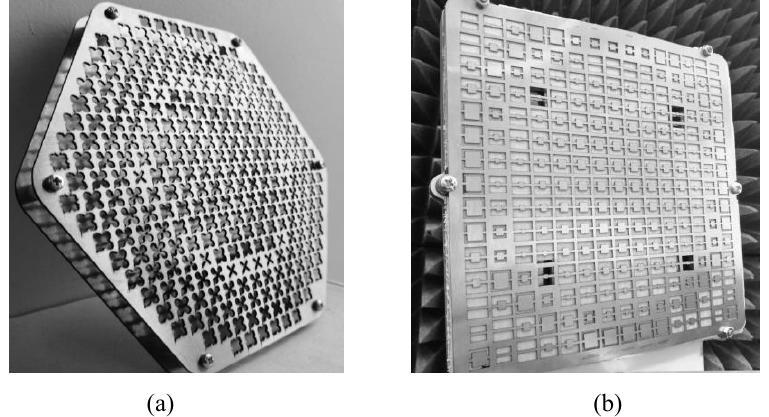
Fig. 6. Manufactured samples of full-metal reflectarray antennas: (a) based on single-layer crossed dumbbell slots; (b) based on two-layer square-loop slots.